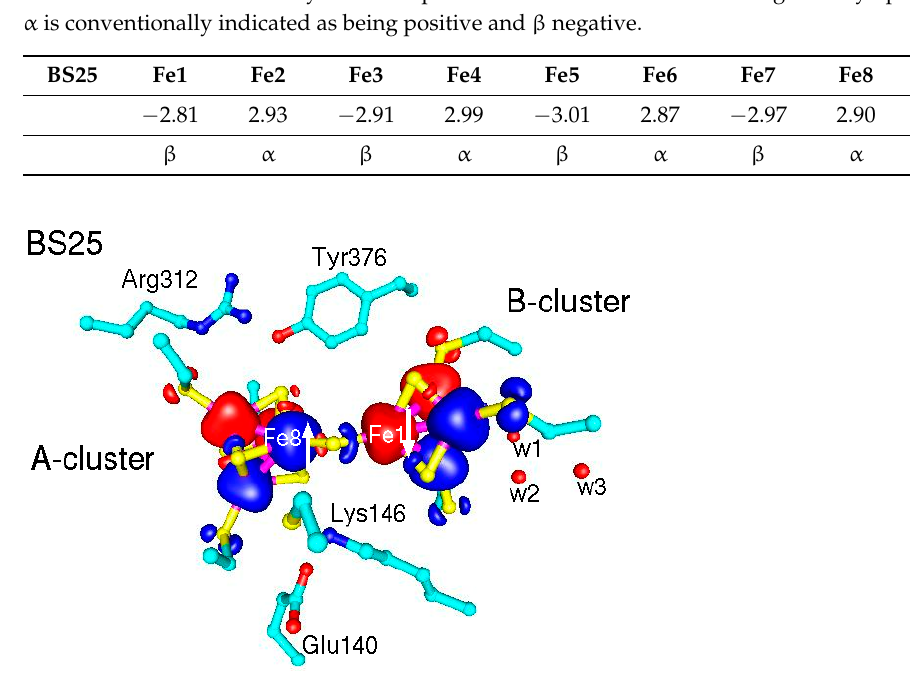
Table 2. Relative quantum mechanical/molecular mechanical (QM/MM) and QM energy differences (kcal/mol) and aver ‐ age QM/MM bond lengths (Å) for each cubane cluster are reported for each of the nine BS ( S = 0) configurations. BS